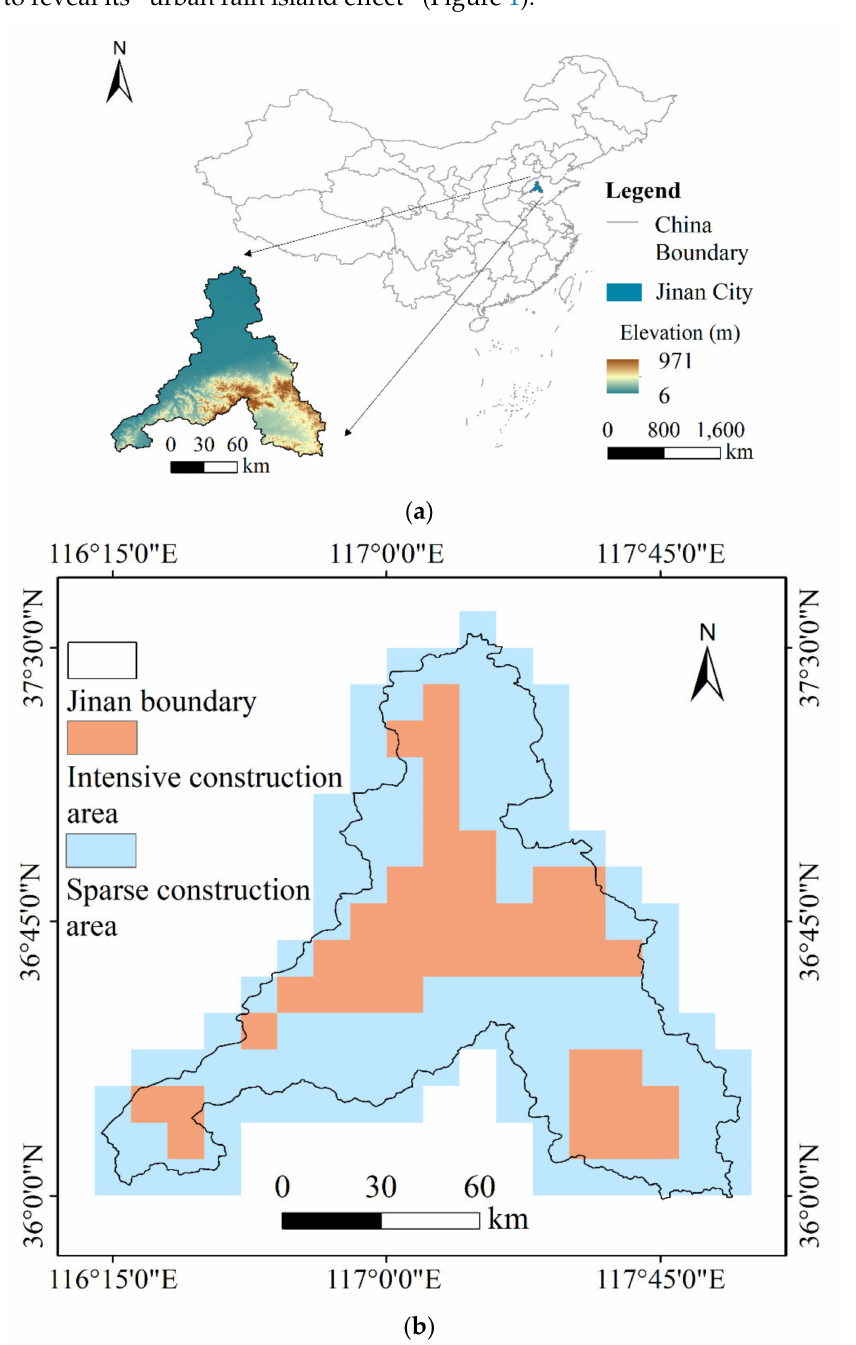
Figure 1. ( a ) Geographic location and elevation of Jinan City; ( b ) impervious surfaces zoning of Jinan